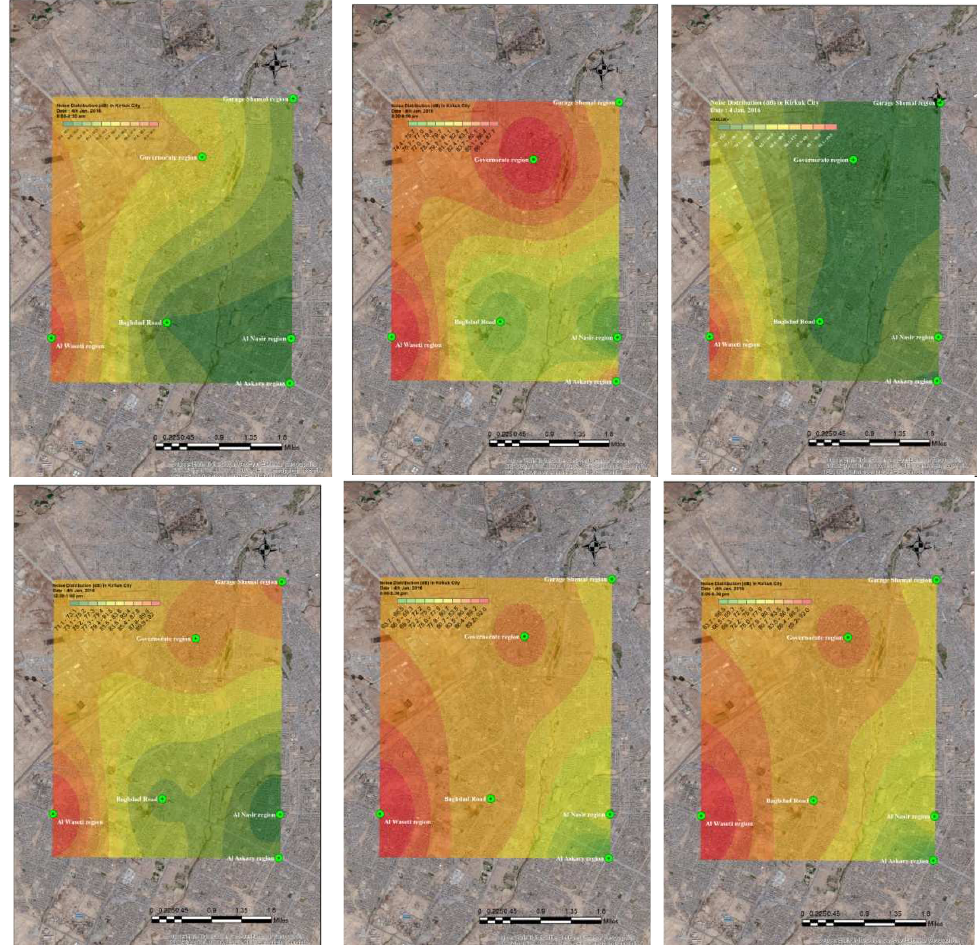
Fig. 3. Hourly Noise Distribution for the peak morning and evening traffic flow 4 Jan. 2015 Kirkuk